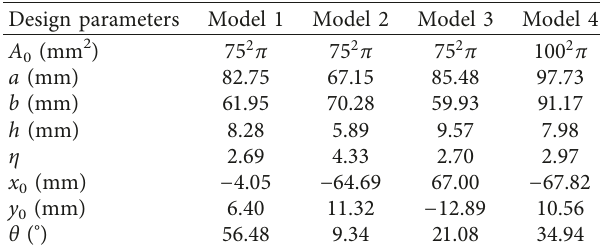
Table 7: Optimal results of a rectangular plate with flanging cutout.